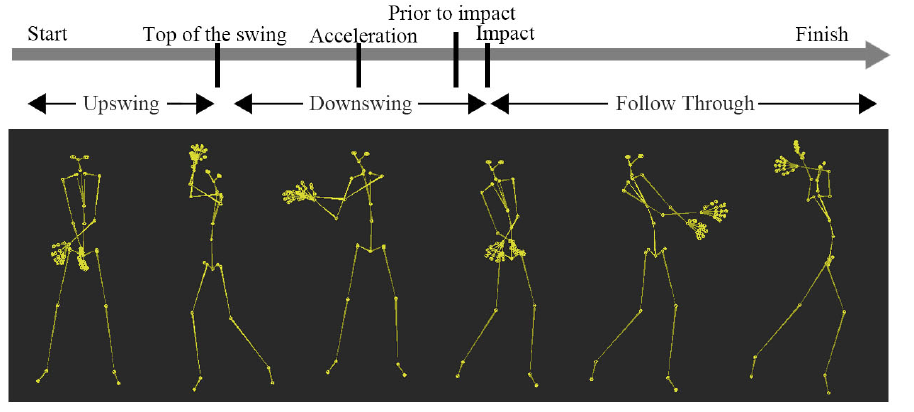
Figure 7. Selected events of a golf swing motion [23].